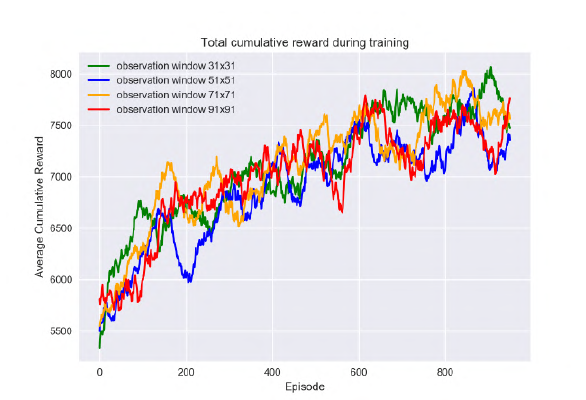
Figure 4. Average cumulative reward for different observation windows size.